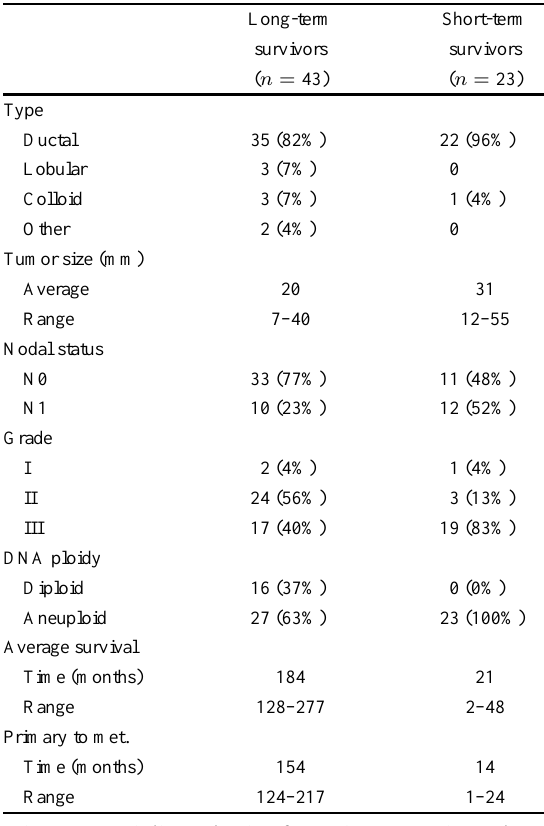
Clinicopathological characteristics of primary breast carcinomas from the selected patient groups of long-term survivors ( n =